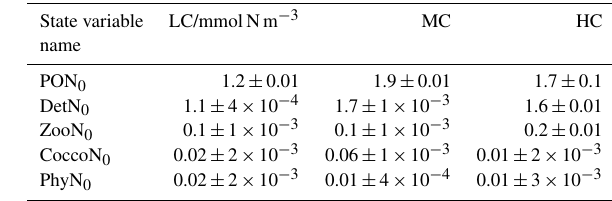
Table 4. Mean initial values of PON (PON 0 ), detritus (DetN 0 ), zoo- plankton (ZooN 0 ), coccolithophores (CoccoN 0 ), and bulk phyto- plankton (PhyN 0 ) according to posterior of the (initial condition) parameter estimates of three solutions: low, medium, and high cal- cification (LC, MC, and